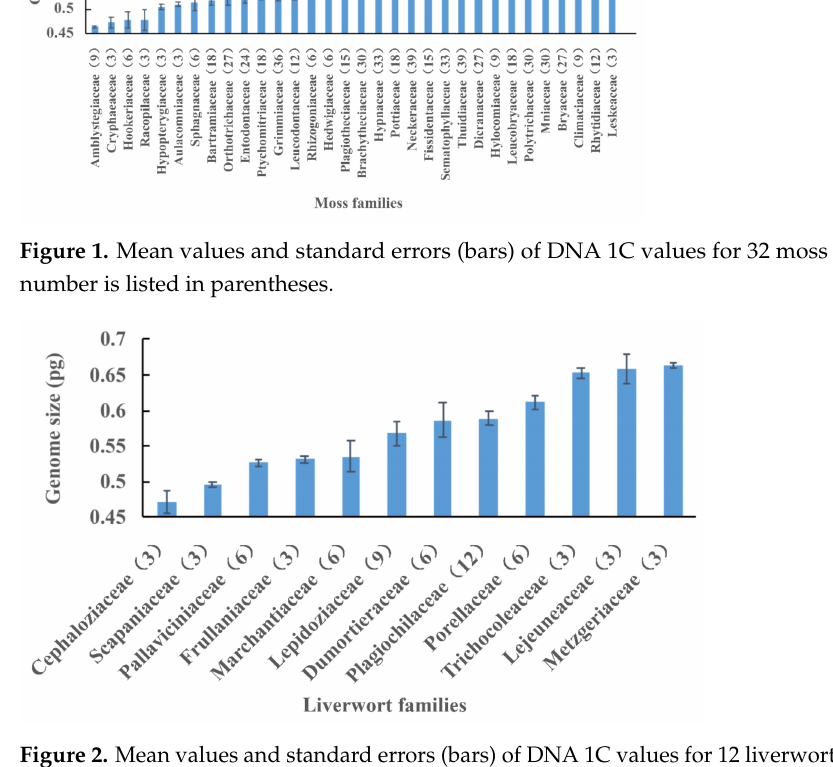
Figure 2. Mean values and standard errors (bars) of DNA 1C values for 12 liverwort families. Sample number is listed in